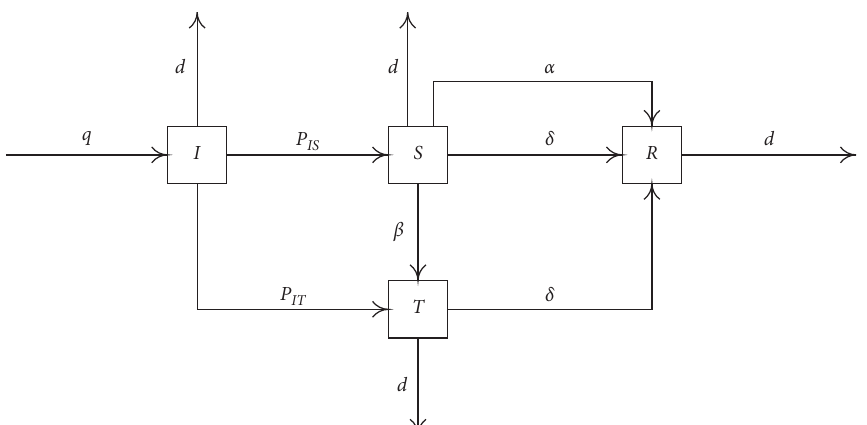
Figure 1: The dynamic process of rumor propagation.